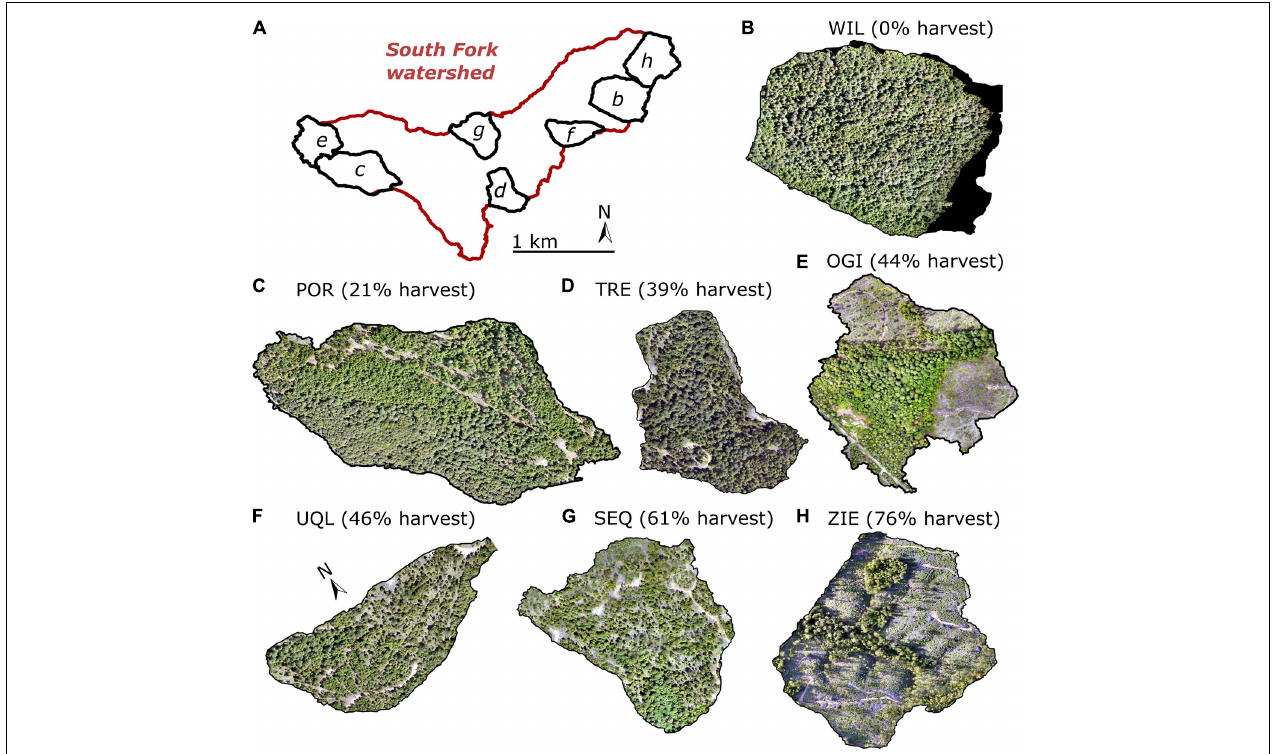
FIGURE 6 | Orthomosaics showing harvested sub-watersheds and a control sub-watershed (WIL). Panels (B–H) are marked on the map in panel (A) . The images for the orthomosaics were collected with an unmanned aerial system (UAS) in spring 2020 after the Third Experiment harvesting was